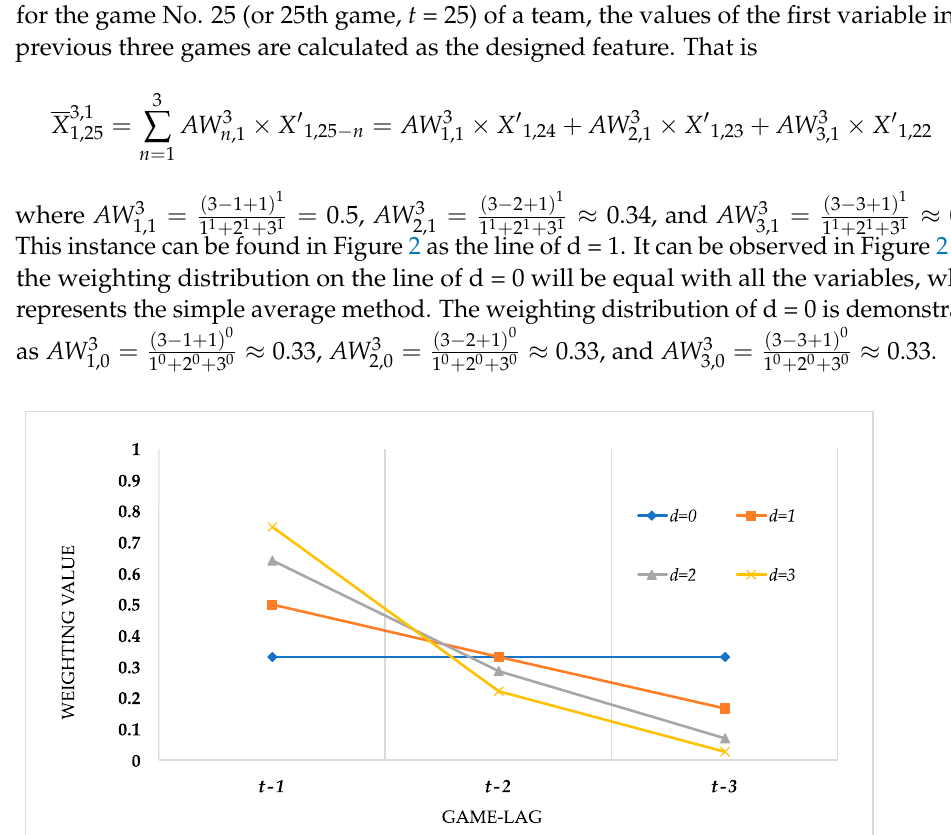
Figure 3. Weighting distribution of each data point with different weighting control parameter ( d ) from 0 to 3 under game-lag = 4.